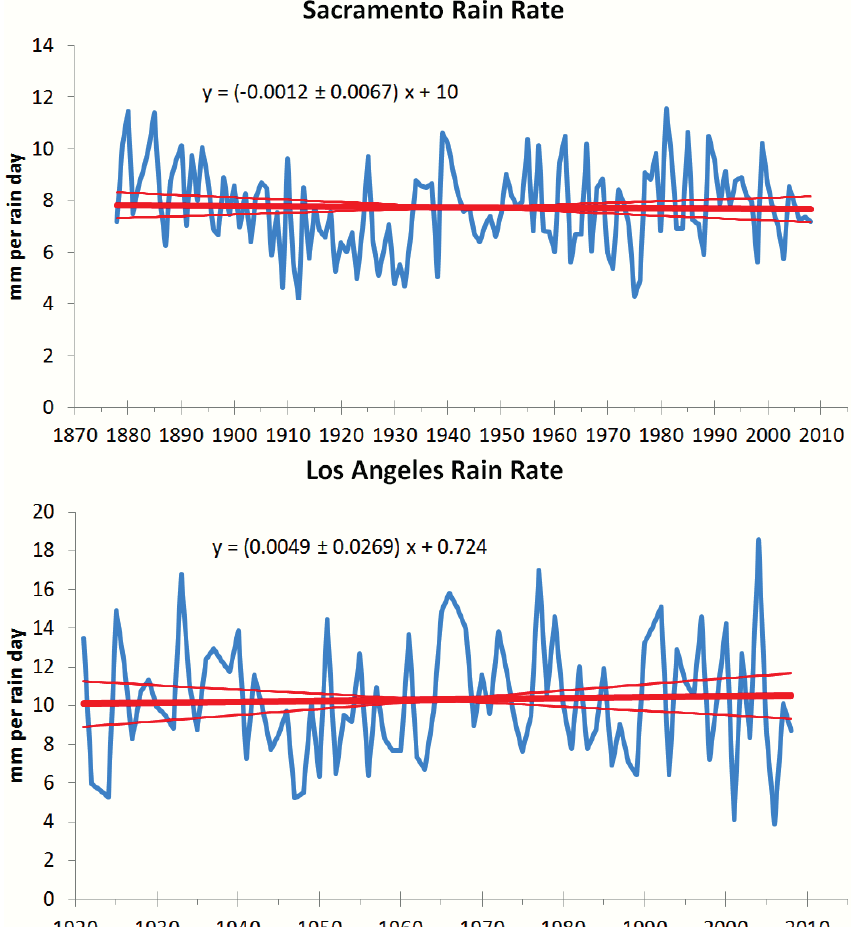
Figure 5. Average precipitation per day (for days with a measurable amount of rainfall) for the two longest daily records, Sacramento ( top ) and Los Angeles ( bottom ). Units of the slope in the trend equations are (mm of rain per rain day)/year. Neither record contains a significant trend in the daily rain rate, or rain intensity.